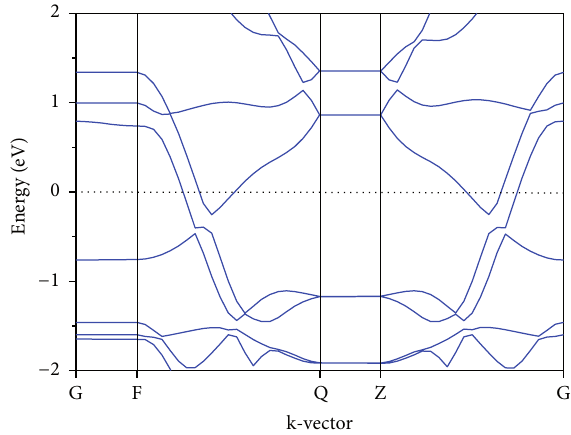
Figure 5: The electronic band structure of N2-doped single walled armchair (3,3) BNT. The Fermi level is set corresponding to zero energy and represented by dotted line.